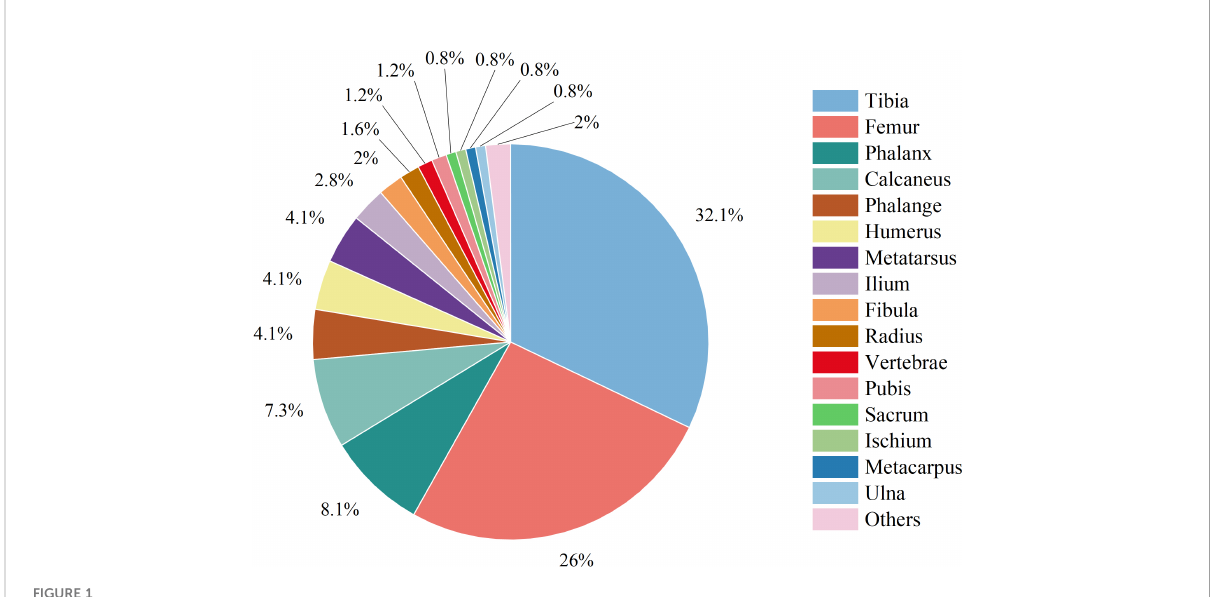
FIGURE 1 Distribution of single infection